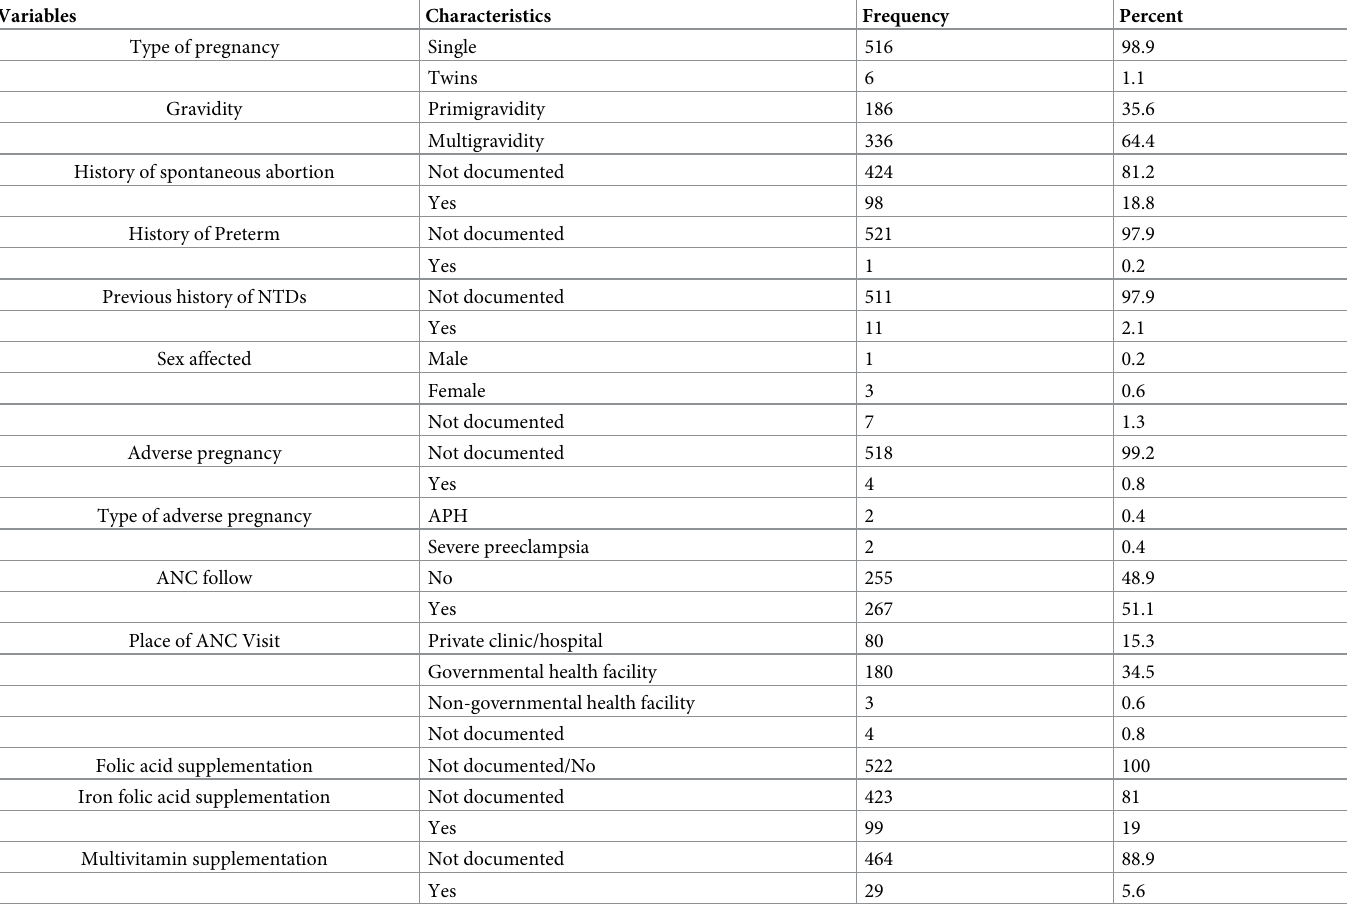
Table 2. Reproductive and ANC characteristics of pregnant women, Eastern Ethiopia, data from